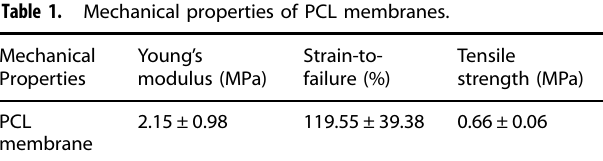
Fig. 2 The biomechanical characteristics of the asymmetric PCL/Pluronic F127. a FT-IR spectra of PCL bead and PCL membranes. b Strain- stress curves of PCL membranes. FT-IR Fourier transform-infrared, PCL polycaprolactone. Table 1. Mechanical properties of PCL